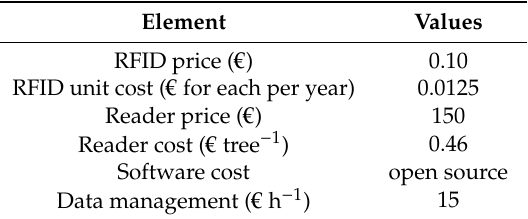
Table 3. Elements for calculating the technological traceability system (TTS) application cost. As for crates, radio frequency identification (RFID) lifespan on standing trees was considered to be 8